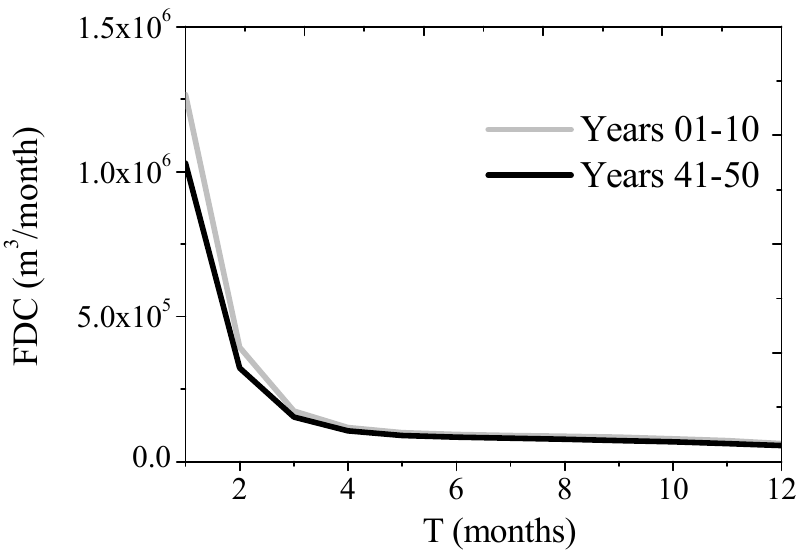
Figure 8. Flow duration curves in terms of cumulated volumes equaled or exceeded for a certain number of months each year. Grey line refers to the average of the years from 01 to 10, while black line refers to the average of the years from 41 to 50. Each point is the average of the 500 generated rainfall time series realizations, in descending order.